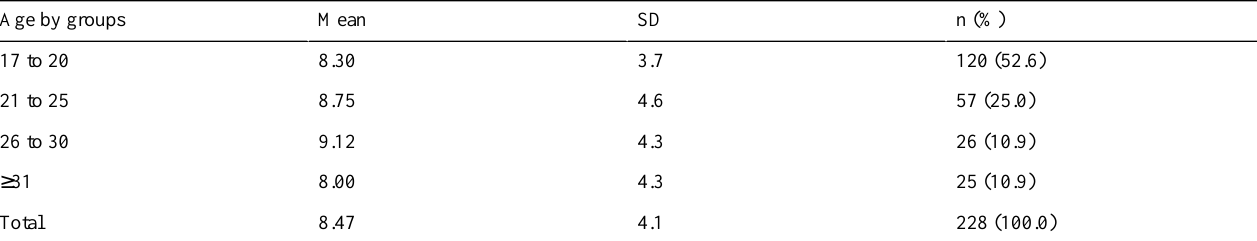
Table 1. Smartphones general skills scores per age group reported as mean, SD, and number of students per group.